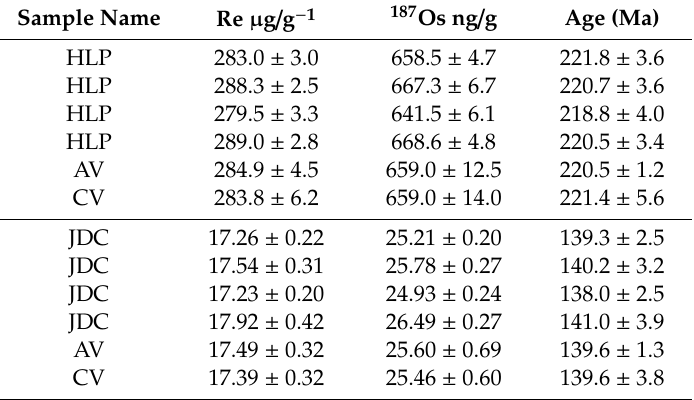
Table 1. Analytical results for molybdenite RM, HLP, and JDC mixed with 3 g of